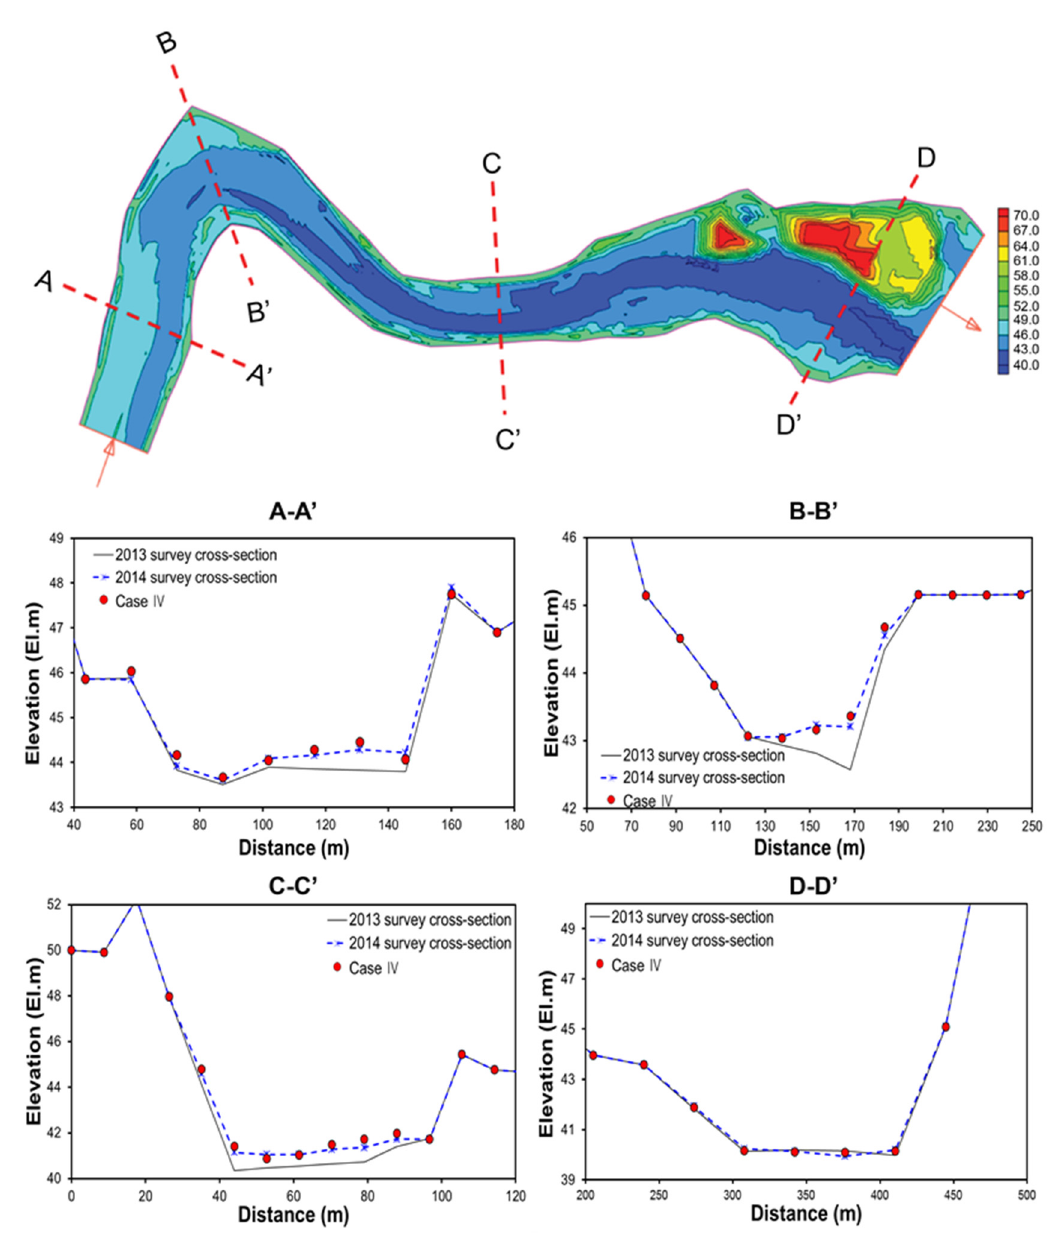
Figure 10. Bed change result at representative cross sections aspect of scenario case IV.